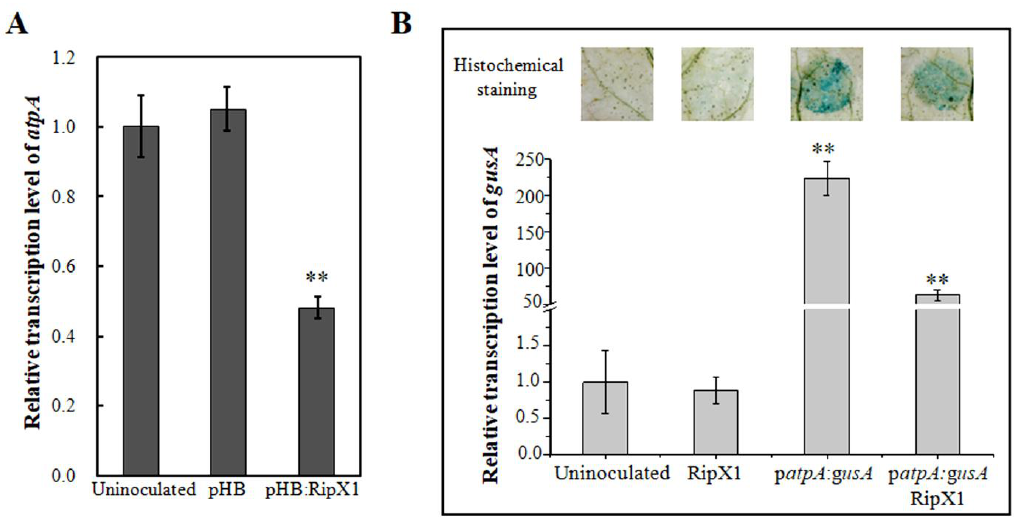
Figure 6. RipX1 suppressed atpA transcription. ( A ) Reduction in atpA transcription in N. benthamiana transiently expressing RipX1. The plants transformed with the pHB empty vector were used as controls. ( B ) Examination of atpA promoter activity. For qRT-PCR analyses, the transcript level in uninoculated plants was set to 1, and the level in other samples was calculated relative to that. Error bars indicate standard deviations of three individual replicates, and asterisks denote statistical significance (** p ˂ 0.01).